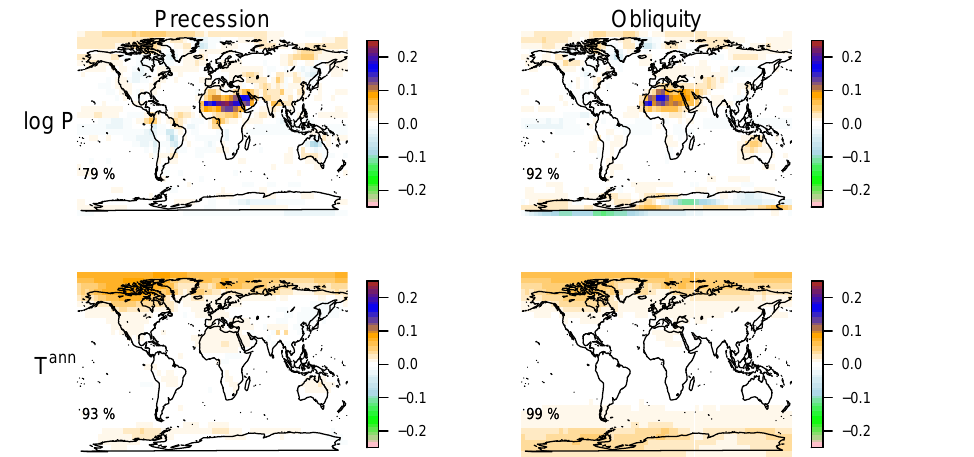
Figure 8. First eigenvectors of T { e(cid:36) } and obliquity T ε for annual precipitation (log) and annual surface temperature, along with the fraction of the explained variance by these eigenvectors. These eigenvectors are referred to here as the fingerprints.